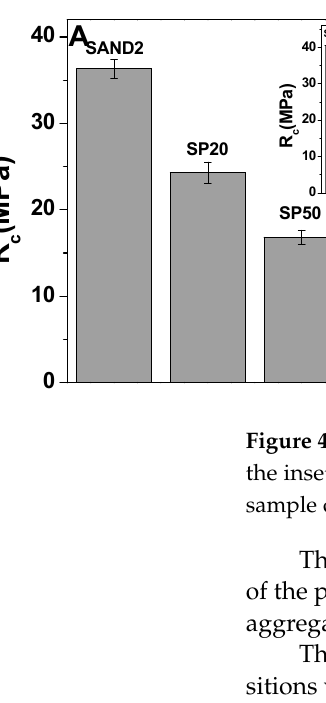
Figure 5. Sections of ( A ) SAND1, ( B ) SAND2, ( C ) SP20, ( D ) SP50, ( E ) SP80, ( F ) PET1, ( G ) PET2, ( H ) PET3. The values obtained are compatible with other similar studies [20,42]. 3.4. Thermal Conductivity Figure 6 reports the thermal conductivity of the samples. Sand ‐ based specimens resulted in being more insulating than the normalized mortar [29,30]. In fact, these conglomerates showed values ranging 0.7–1.3 W/mK with respect to ~2 W/mK of the